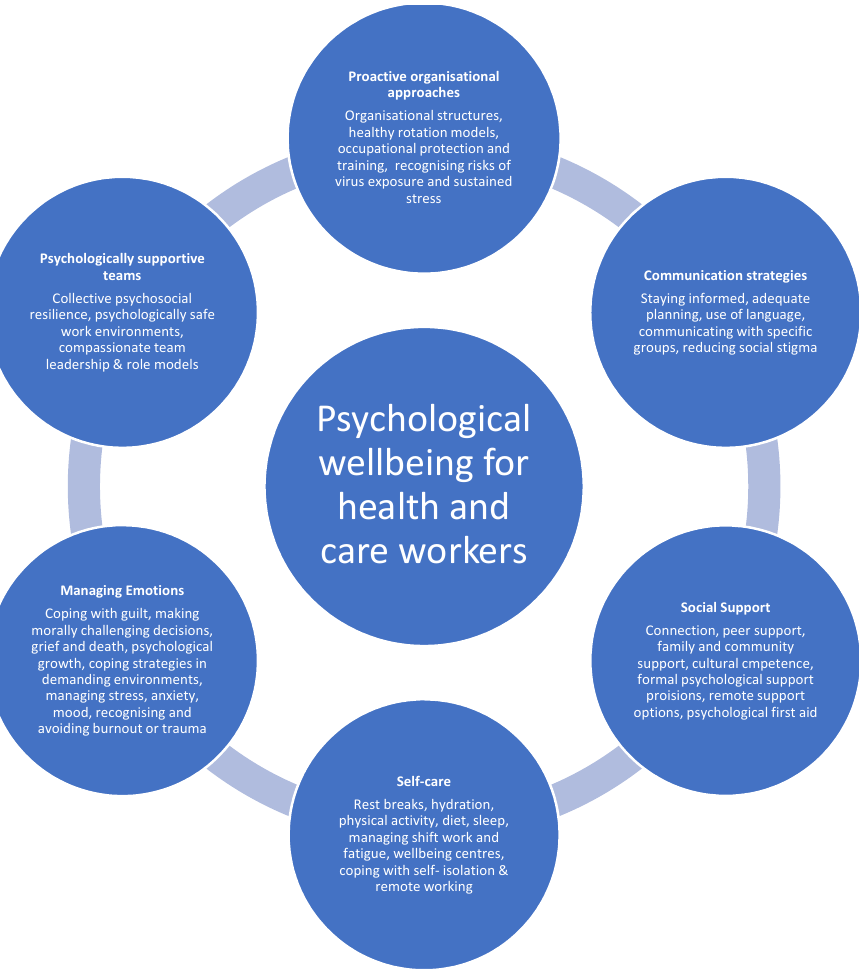
Figure 1. Conceptual model for mitigating the impacts of COVID-19 on health and care workers.